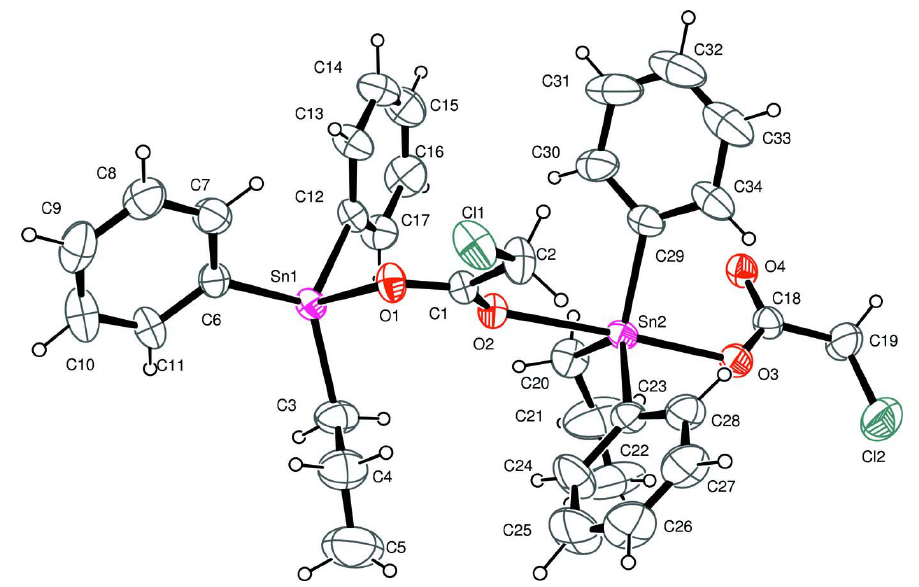
The asymmetric unit of the title compound as a portion of the polymeric chain, showing the atom labelling scheme and displacement ellipsoids drawn at the 30% probability